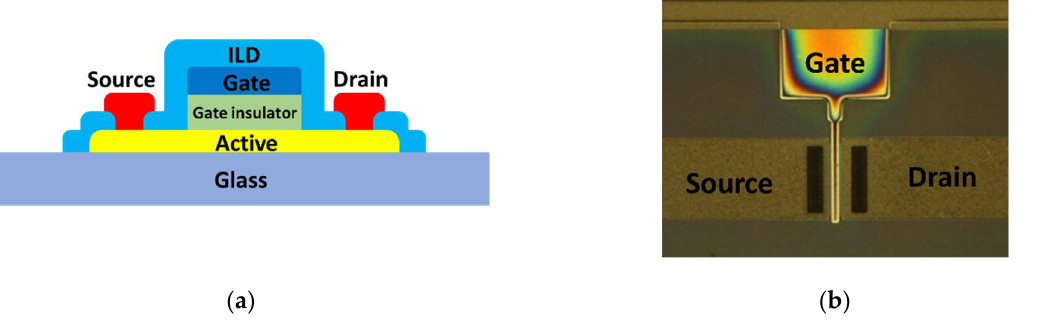
Figure 10. ( a ) Cross-sectional structure of the top gate a-IGZO TFT used for the fabrication of the circuits; ( b ) microscopic view of the fabricated a-IGZO TFT. circuits; ( b ) microscopic view of the fabricated a-IGZO